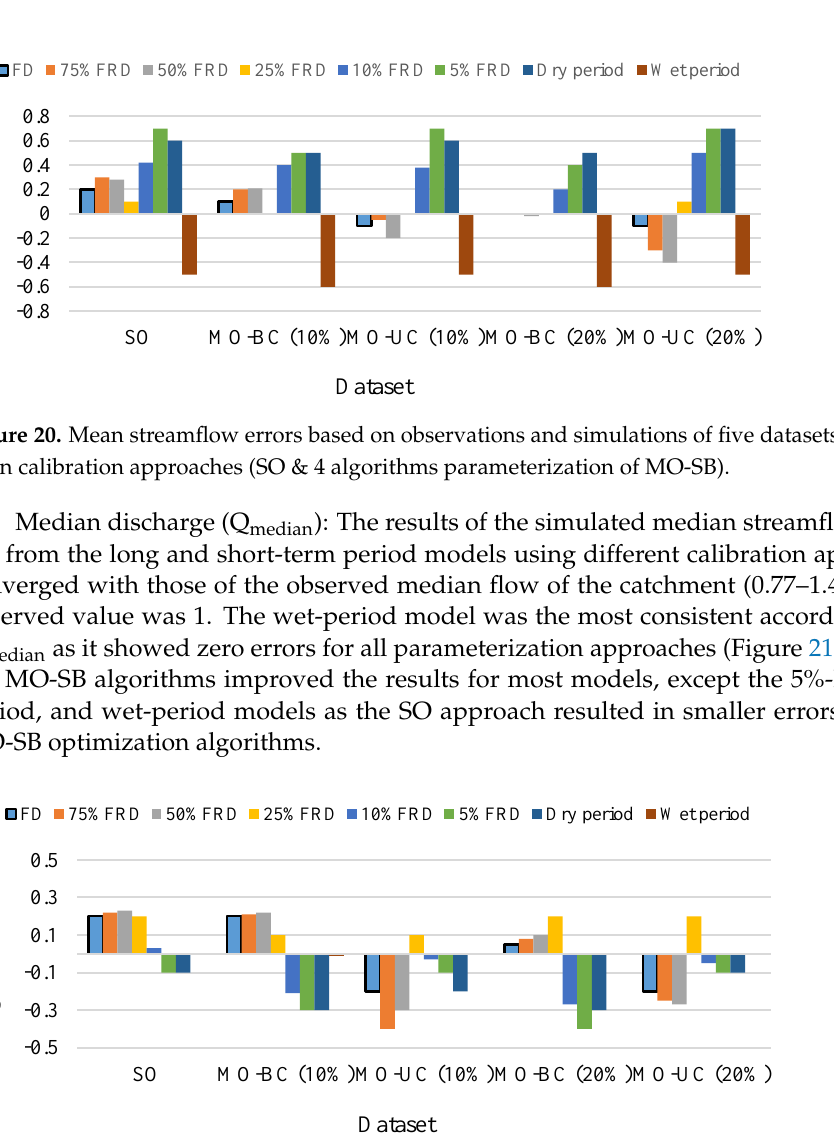
Figure 21. Median discharge errors based on observations and simulations of five datasets using two main calibration approaches (SO & 4 algorithms parameterization of MO-SB).